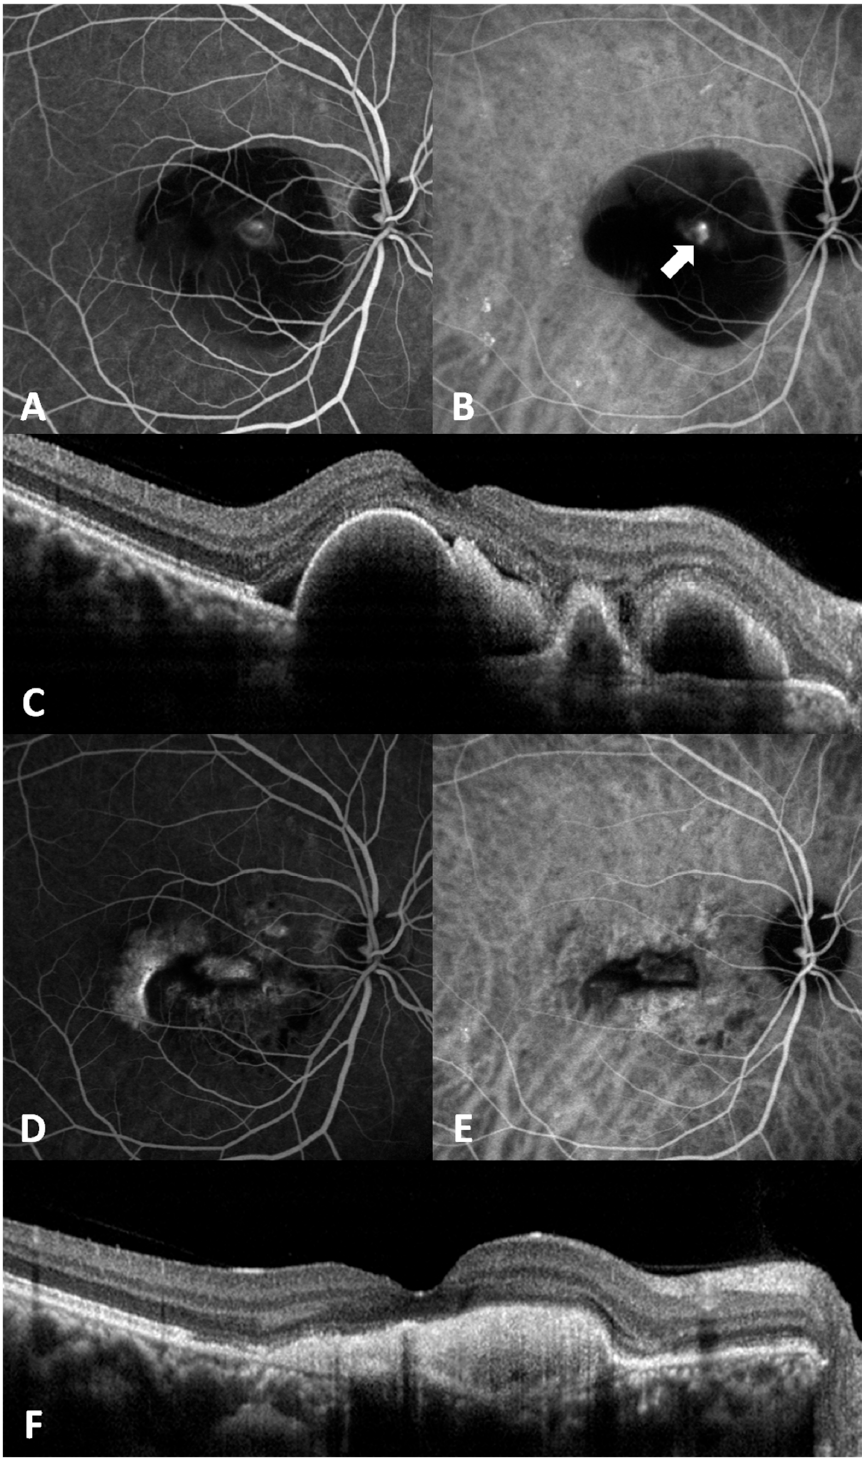
Figure 3. This is a 40-year-old man with PCV in the right eye. ( A – C ) were images prior to treatment, and ( D – F ) were images 6 months after IVA/PDT treatment. ( A ) Fluorescein angiography (FA) showed an occult leakage. ( B ) Indocyanine green angiography (ICGA) showed a polypoidal lesion (arrow). ( C ) Optical coherence tomography (OCT) revealed polypoidal lesions and subretinal fluid. ( D ) FA showed staining without active leakage. ( E ) ICGA showed complete regression of the polyp. ( F ) OCT revealed no subretinal fluid, even though pigment epithelial detachment